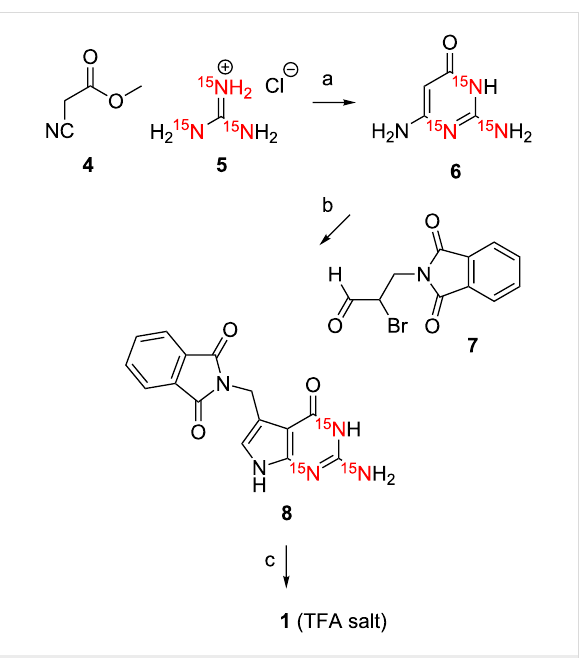
Scheme 2: Synthesis of [ 15 N1, 15 N3,H 215 N(C2)]-preQ 1 base ( 1 ). a) CH 3 ONa (10 equiv) CH 3 OH, reflux, 10 h, RP C18